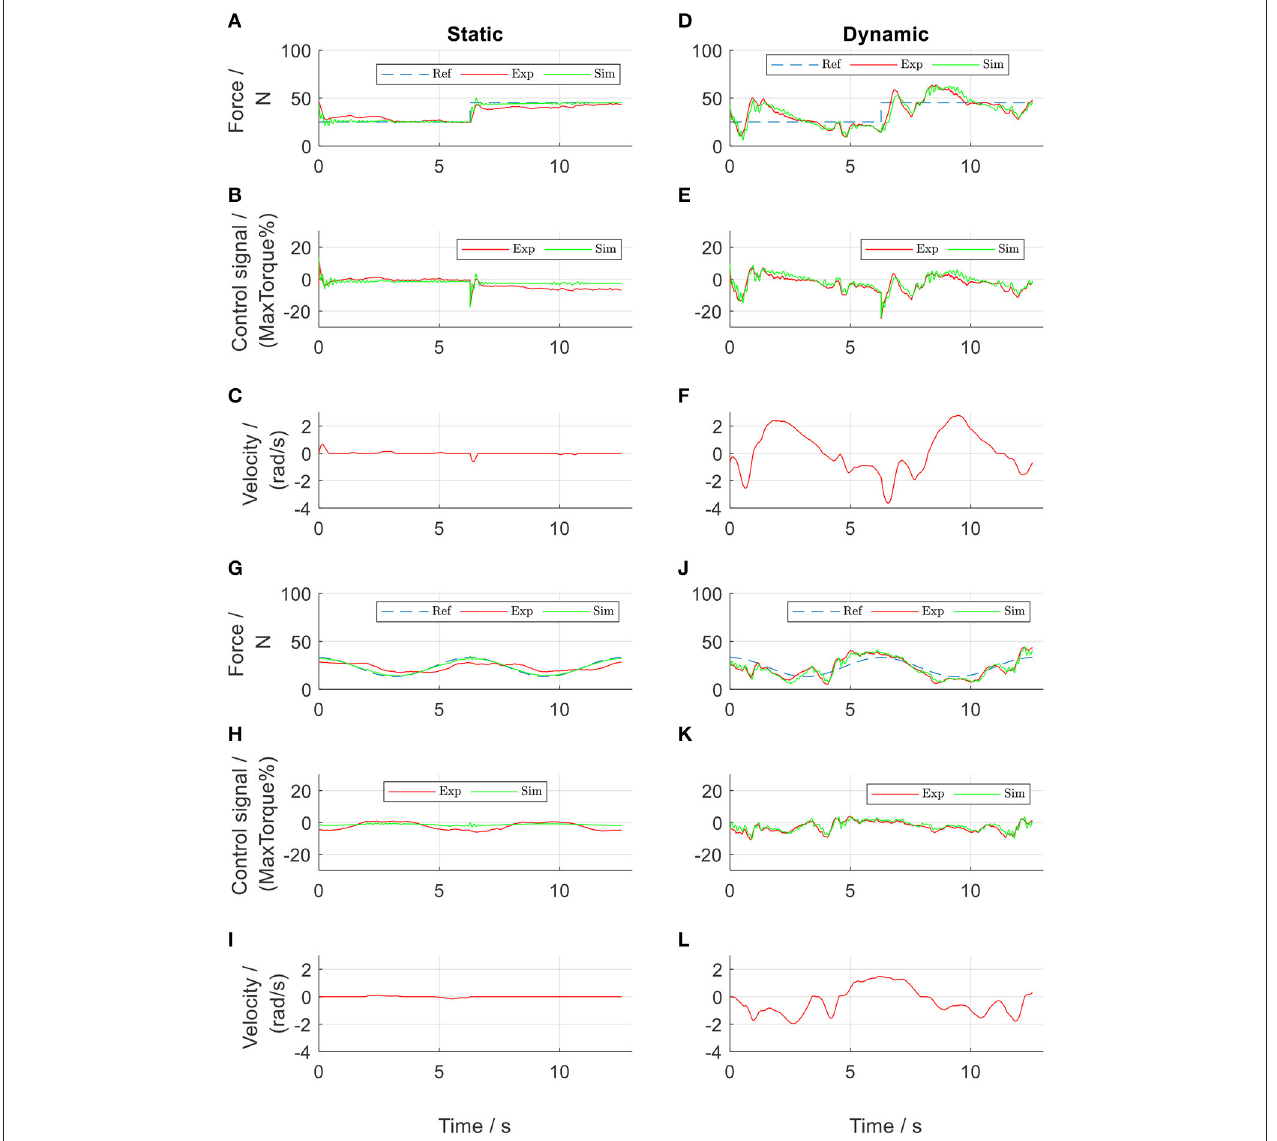
FIGURE 5 | PID-regulated force control of the front thigh actuator. Subplots (A–F) show results from square-wave reference test, while subplots (G–L) show results from sinusoidal reference test. Ref, references; Exp, experimental values; Sim, simulation